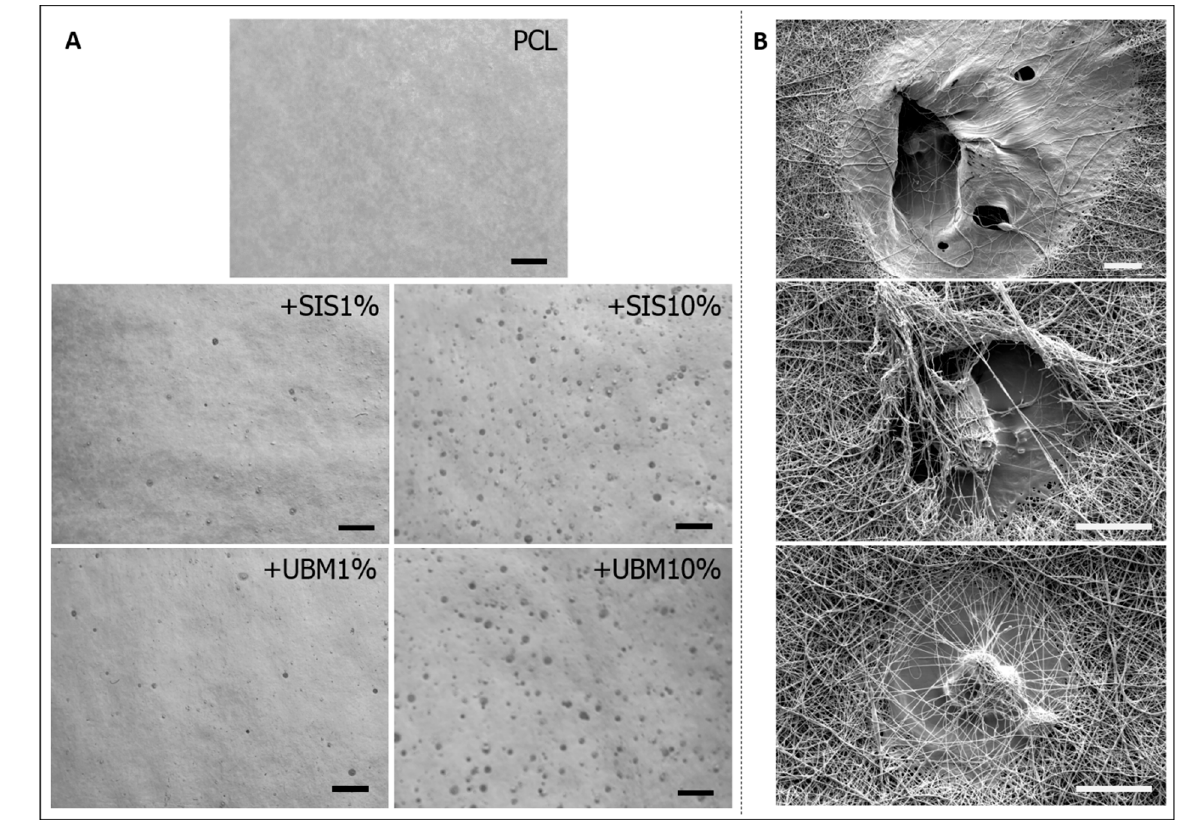
Figure 3. ( A ) Gross images of as-spun electrospun fibres for poly( ε -caprolactone) (PCL) and with the addition of 1% or 10% decellularised tissue powder (dECM—small intestinal submucosa (SIS) and urinary bladder matrix (UBM)) (scale = 5 mm). Images converted to greyscale for observation of ‘wet’ droplets on dECM containing fibre scaffolds. ( B ) Scanning electron microscopy images highlighting the ‘wet’ droplets present within the PCL + SIS10% fibres and the holes these create. Scale bar = 40 µm, magnification ×1000 (top image) and ×2000 (middle and bottom images).